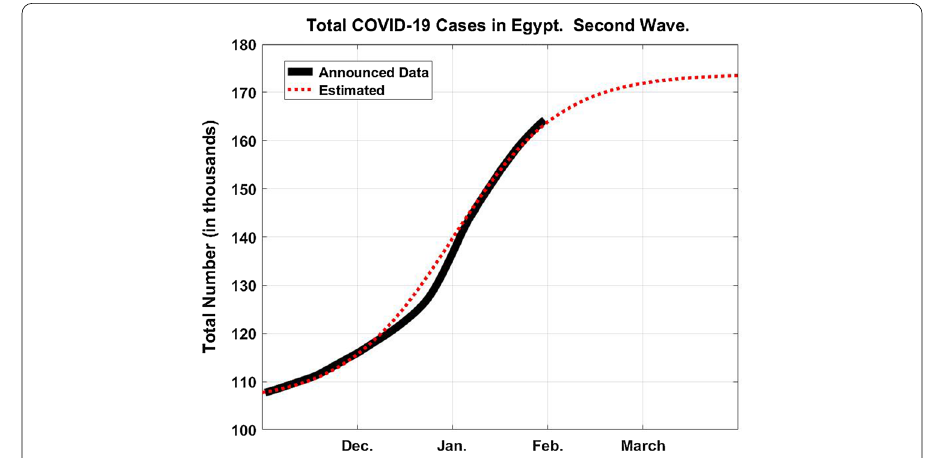
Fig. 4 The total number of COVID‑19 cases in Egypt in the second wave assuming P